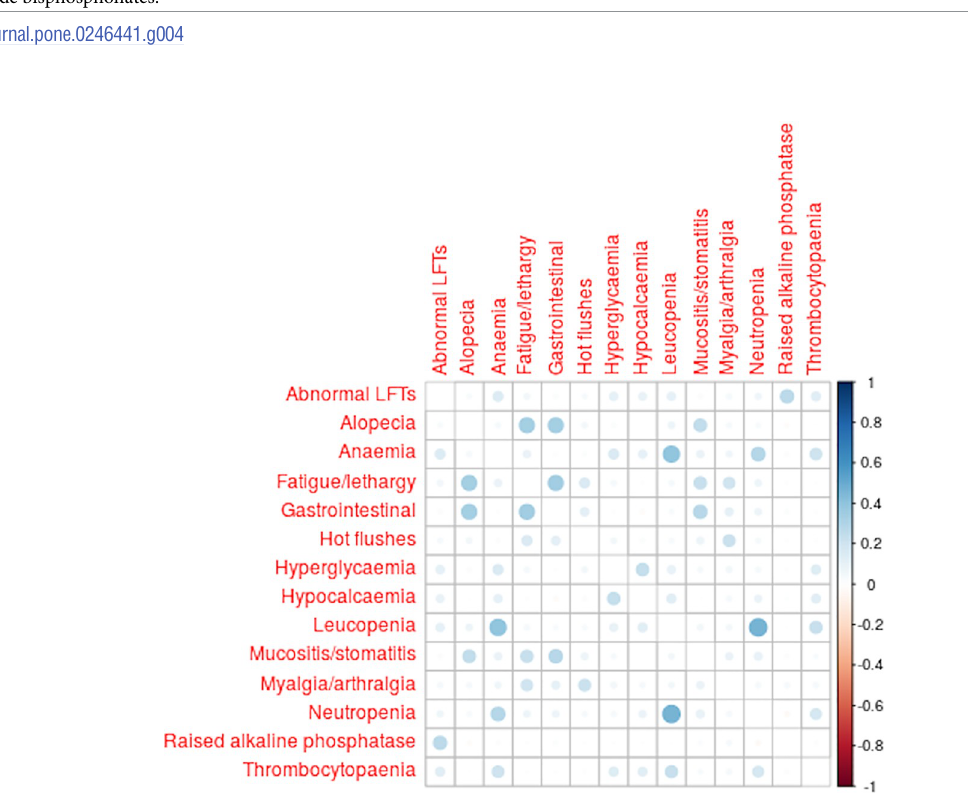
PLOS ONE | https://doi.org/10.1371/journal.pone.0246441 February 5, 2021 17 /